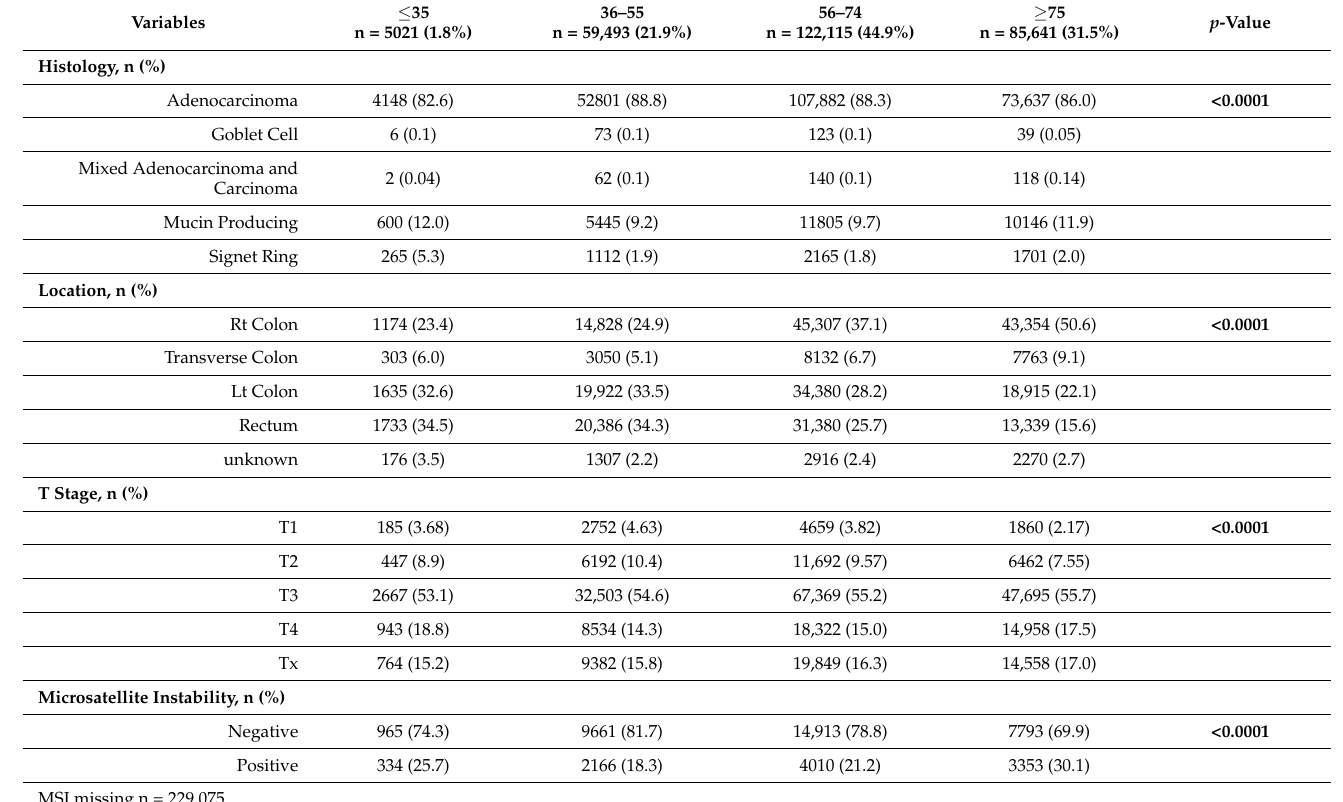
Table 2. Cancer-specific properties by age